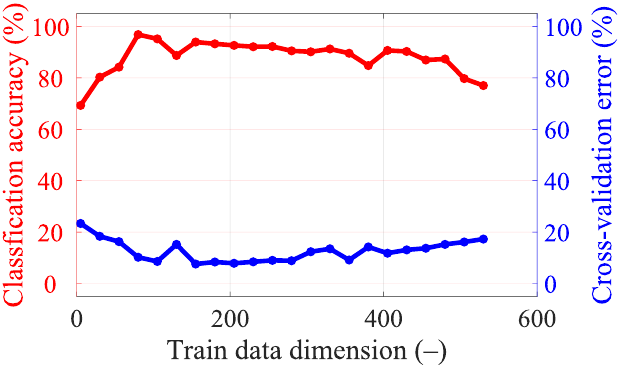
Figure A3. Classification accuracy and cross-validation error for different dimensionality reductions in the data for five frequency points (from 0.8 GHz, step 0.1 GHz, to 1.2 GHz).